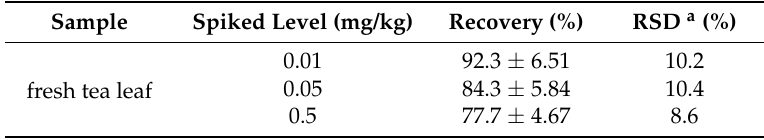
Table 1. Recovery studies of samples spiked with OCDPE by GC ‐ ECD (n = 3).